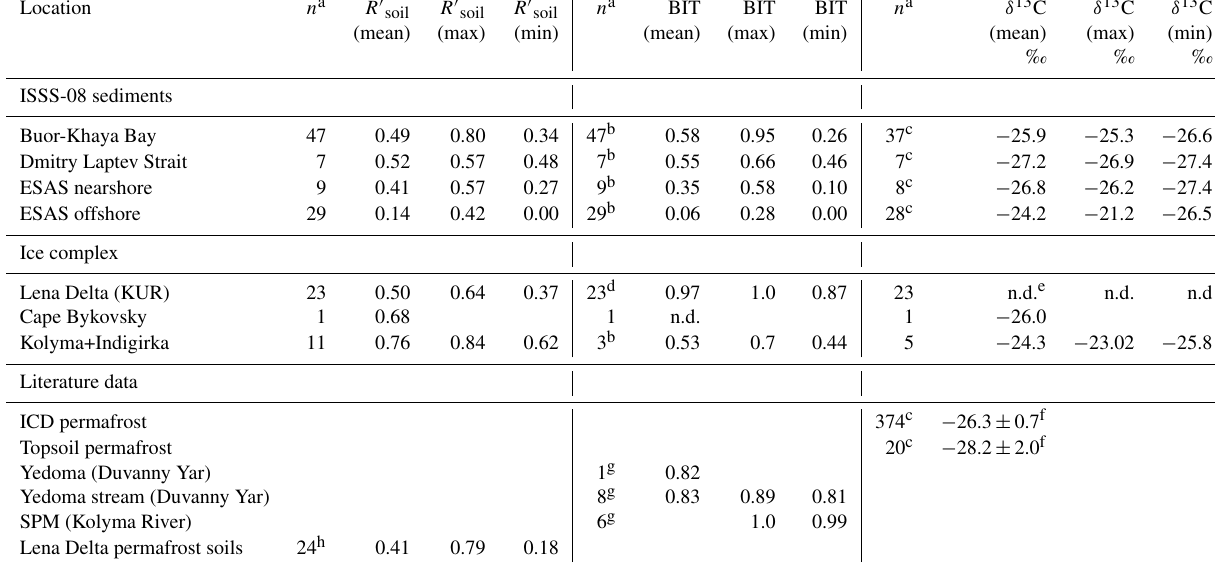
Table 1. Mean, maximum and minimum values for OM proxy values ( R (cid:48) soil , BIT and δ 13 C) by sample group location and type of material. Location n a R (cid:48) soil